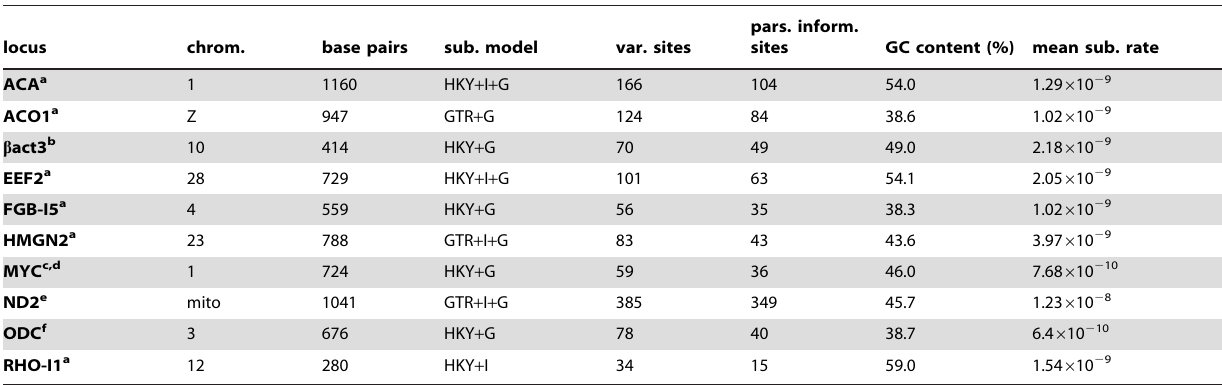
Table 1. Locus information.